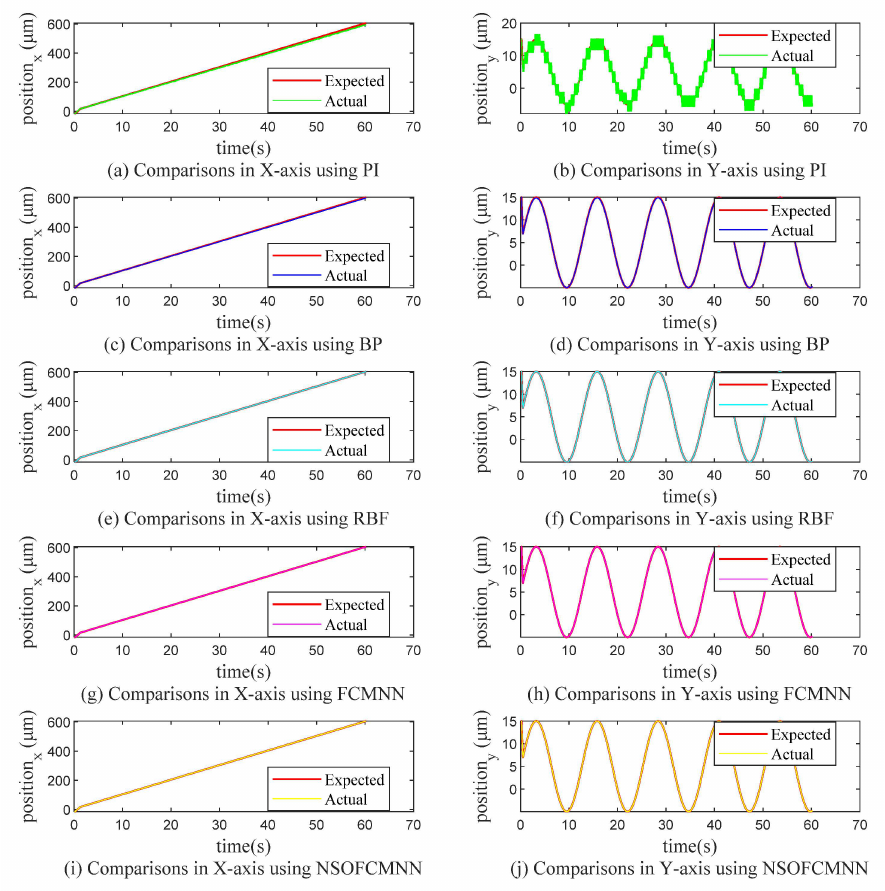
Figure 6. Comparison between the actual trajectory and the expected